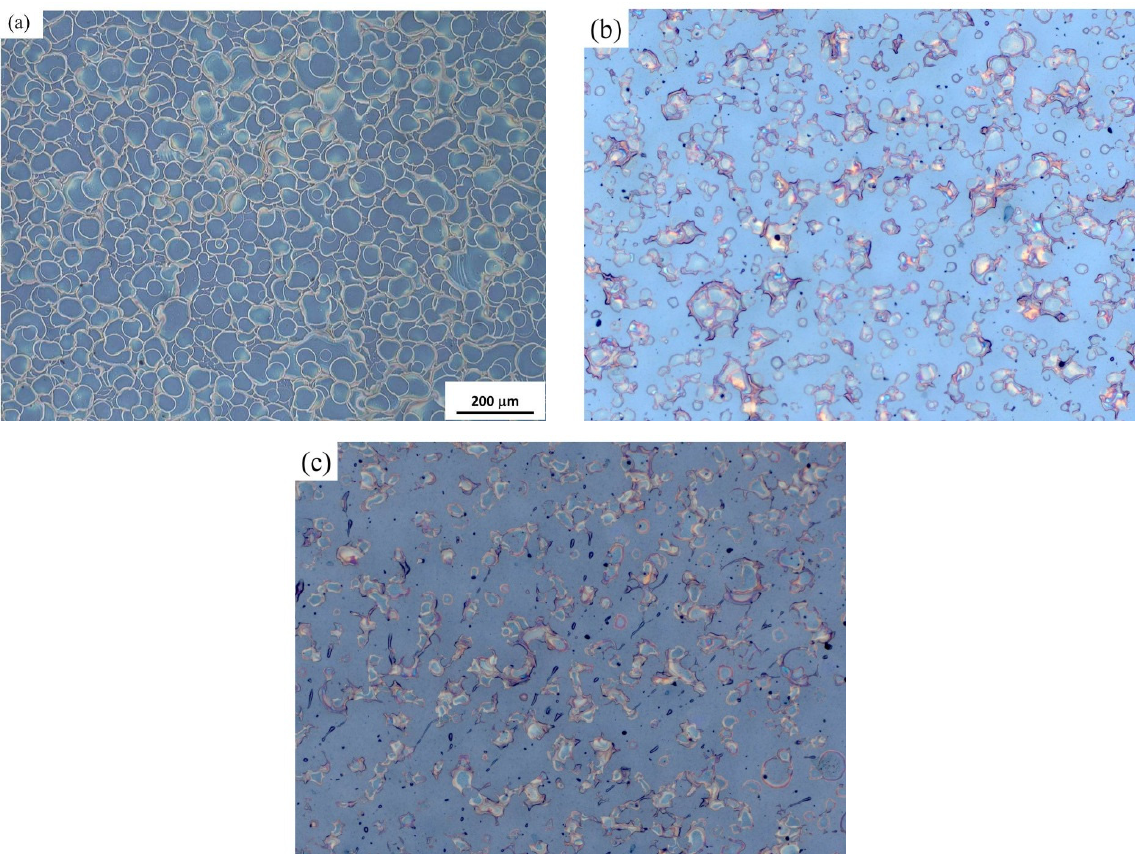
Figure 9. Effect of precursor flow rate on film morphology: surface topography of spray-on P3HT:PCBM films at ( a ) 1 mL/min, ( b ) 2 mL/min, and ( c ) 5 mL/min. Carrier air pressure is 0.2 MPa, the number of spray passes is one, and the precursor solution concentration is 1.8